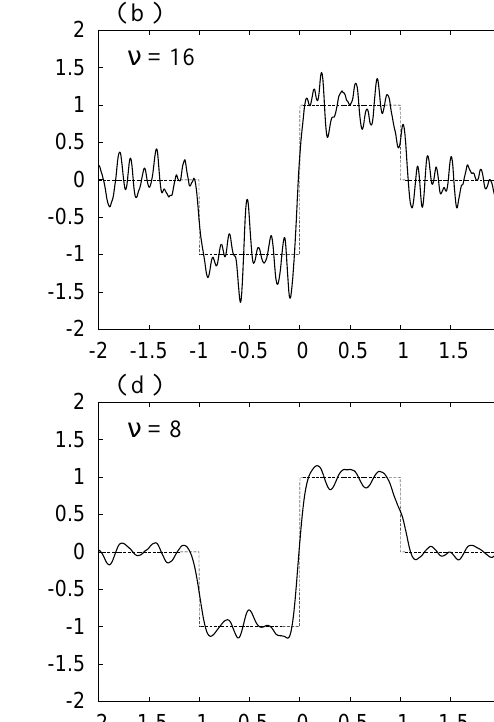
Figure 7. ( a ), ( c ), ( e ): M Mollifier 3. The thinner curves show M